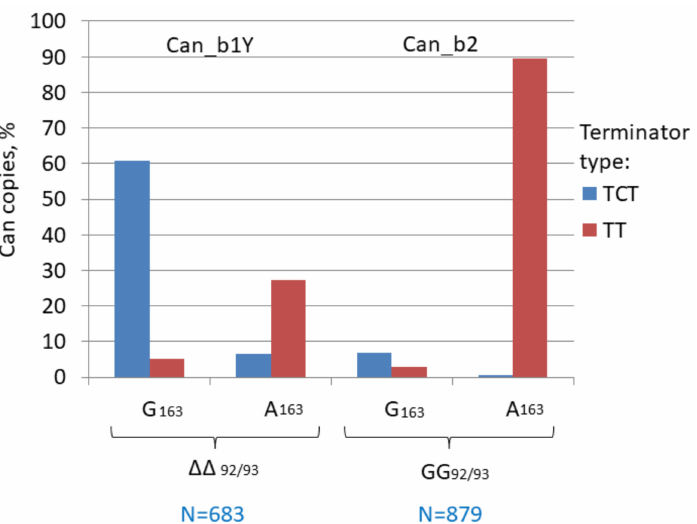
Figure 4. Distribution of TCT and TT terminators among copies of two young Can variants (b1Y and b2). The Can copies present in the German Shepherd genome but missing in the wolf orthologous loci were selected. Can_b2 sequences were distinguished by the GG insertion between Can_b1 positions 92/93 (designated as GG and ∆∆ , respectively). A less definite marker was G or A in position 163 in Can_b1 and Can_b2, respectively. TCT refers to the major TCTTT as well as to TCT, TCTT, and TCT >3 . TT refers to TT, TTT, and T >3